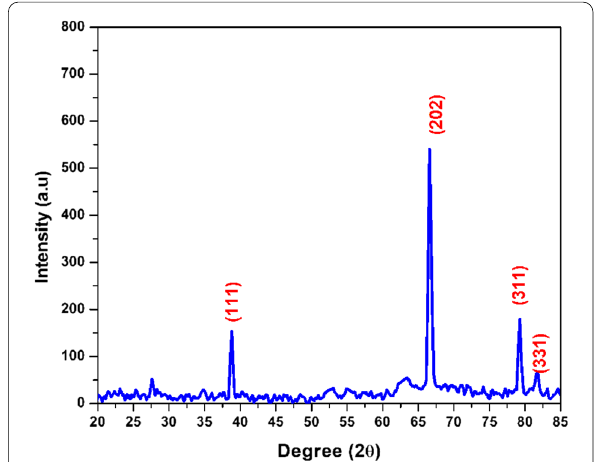
Fig. 1 X-ray diffraction data for a drop cast thin film grown using the Ag